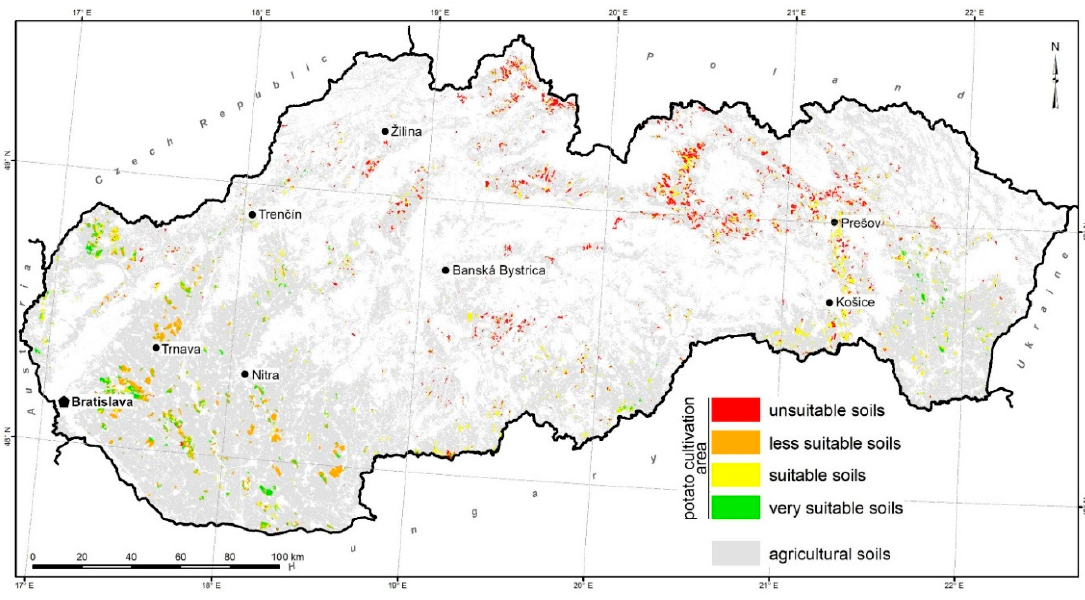
Figure 5. Areas in Slovakia with potato cultivation between 2014–2018 and categorisation their